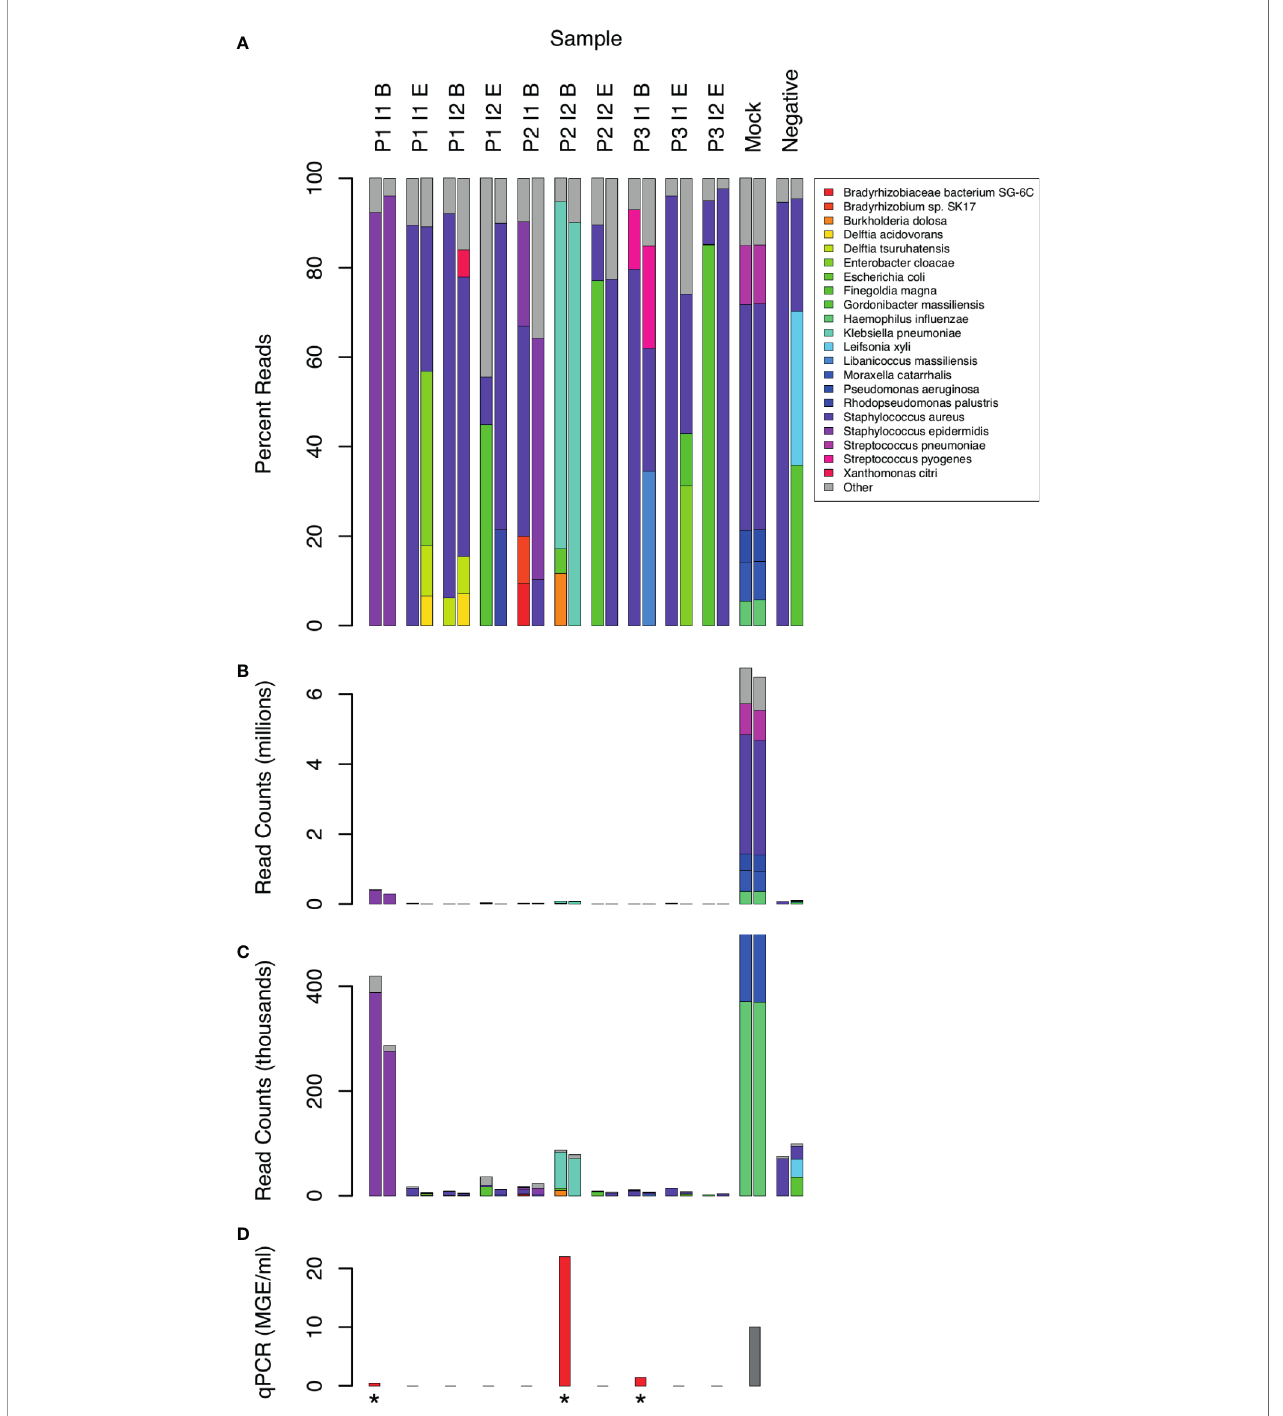
FIGURE 2 | Distribution of bacterial species in sequence reads from 10 CSF samples. Sample labels are as in Figure 1 . 2 samples with low human DNA content were excluded. 21 species that yielded 5% or more bacterial reads in at least one sample are shown by name. Less frequent species assignments are grouped into the “ Other ” category. Reads are plotted as percentages of bacterial reads (A) and counts (B, C) . Panel C shows the same data as B , but scaled to highlight the experimental samples, which had much lower counts than the mock positive control. qPCR measurements of 16S RNA are shown for comparison (D) in units of genome equivalents per ml. The gray bar (Mock) represents a computed, non-experimental value. Measurements above the limit of detection are marked with an